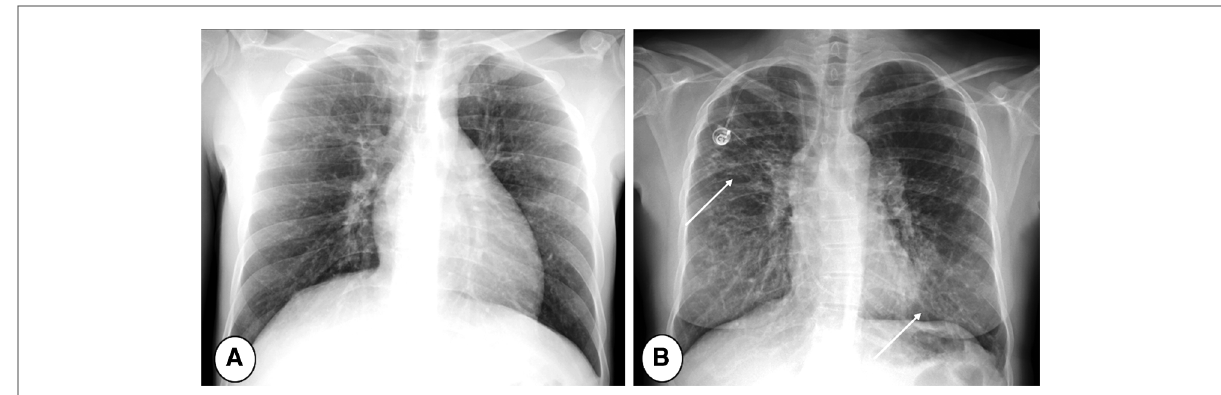
FIGURE 2 Posterior/anterior chest radiographs in ( A ) mild and ( B ) severe cystic fi brosis lung disease. Note the progressive increase of bronchial pathology in the subject with severe disease (B, arrows). The more severe the disease, the more dif fi cult the detection of new abnormalities, especially during respiratory tract exacerbation.